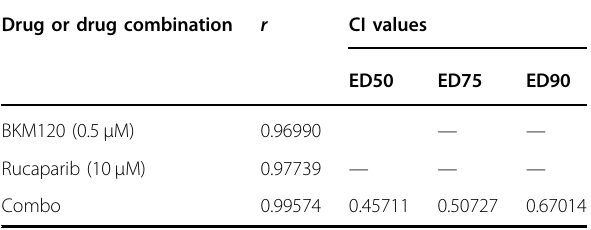
Table 1 Combination indexes (CI) of BKM120 and Rucaparib in U251